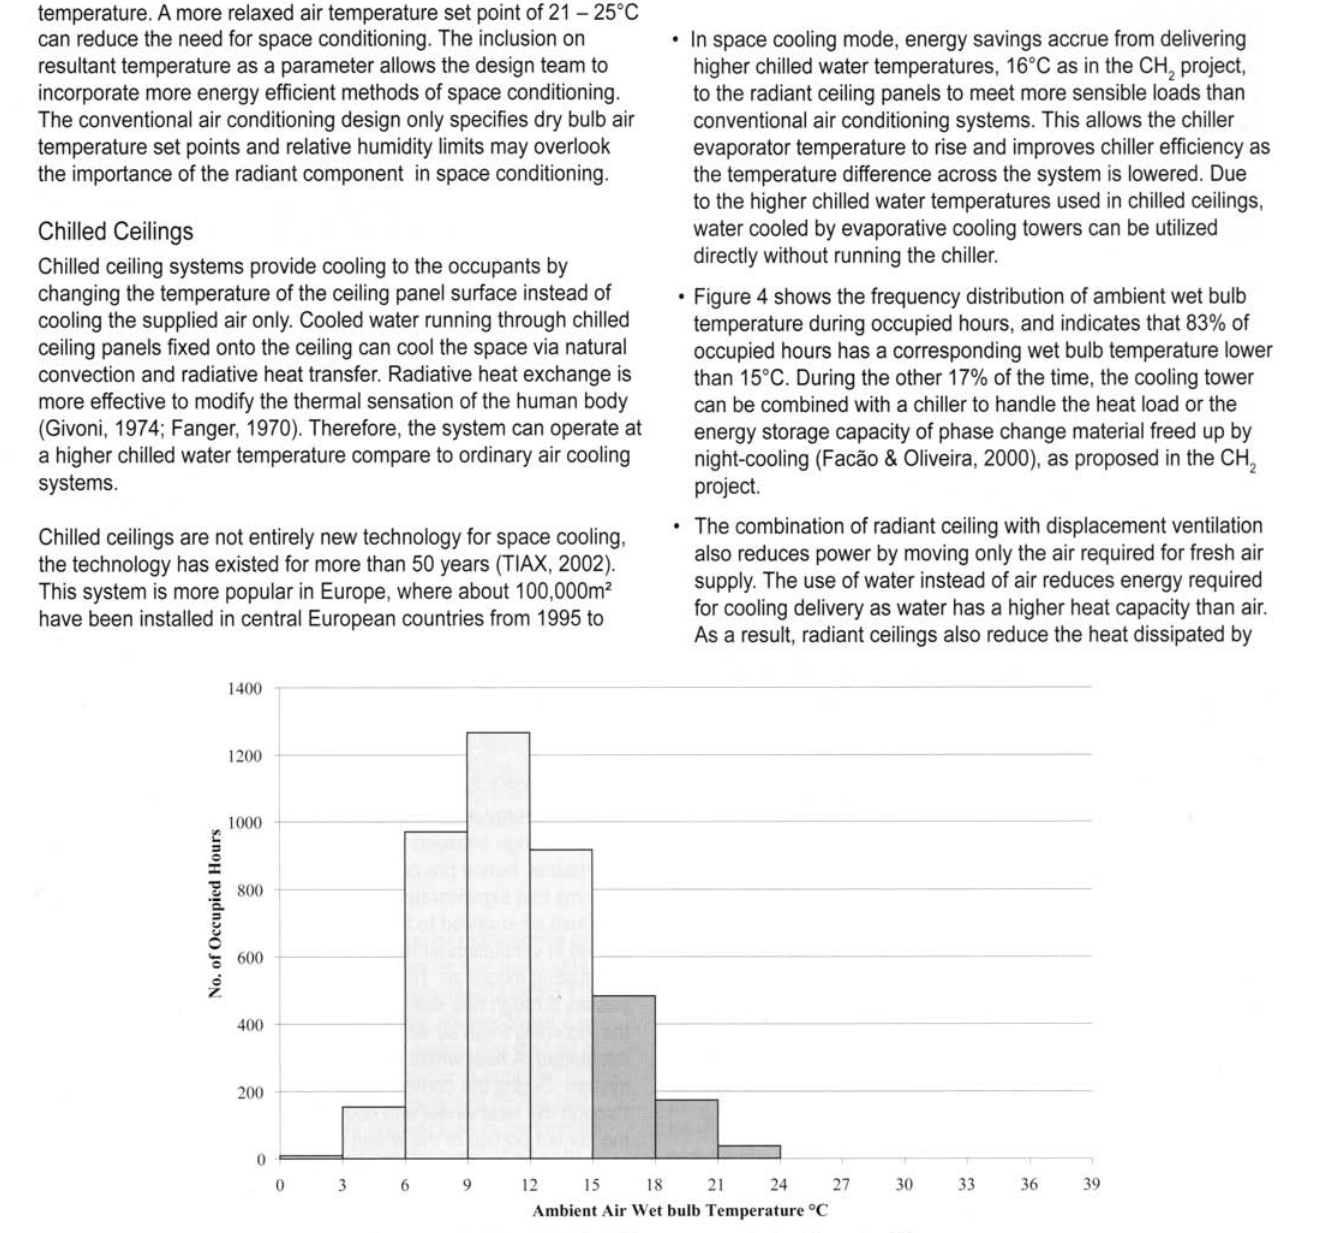
Figure 4: Ambient Wet Bulb Temperature during Occupied